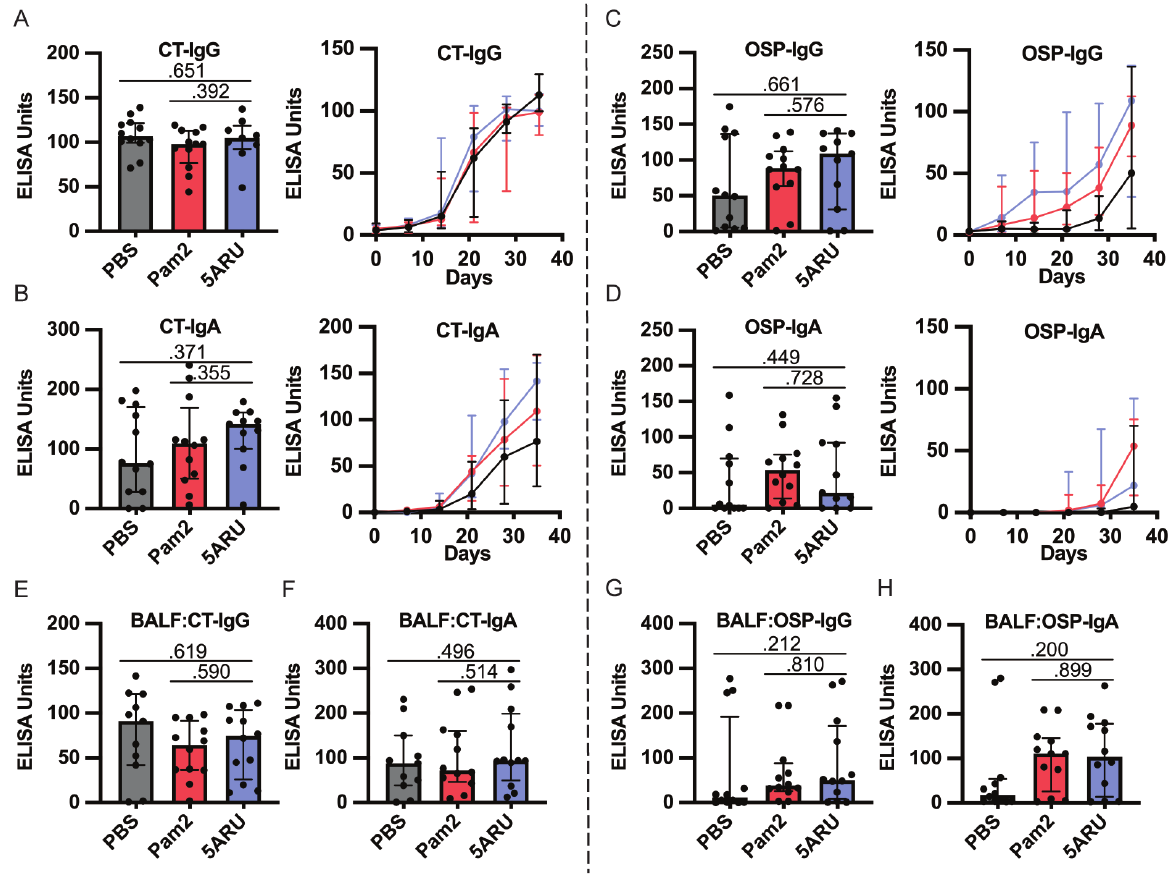
Figure 2. Intranasal 5-A-RU has no effect on protein or polysaccharide-specific antibody responses when administered with a live V. cholerae vaccination. ( A-D ) Serum day 35 endpoint (left) and time- course (right) ( A ) CT-IgG, ( B ) CT-IgA, ( C ) OSP-IgG, and ( D ) OSP-IgA ELISAs. ( E-H ) BAL fluid day 35 endpoint ( E ) CT-IgG, ( F ) CT-IgA, ( G ) OSP-IgG, and ( H ) OSP-IgA ELISAs. Data are represented as ELISA units measured kinetically and normalized to positive control pooled serum from WT B6 mice intranasally vaccinated with live V. cholerae . Data are represented as Median with IQR from 3 independent experiments. n=11-12 mice per group. * P < 0.05, ** P > 0.01, *** P > 0.001, *** P > 0.0001 by 2-tailed Mann- Whitney U